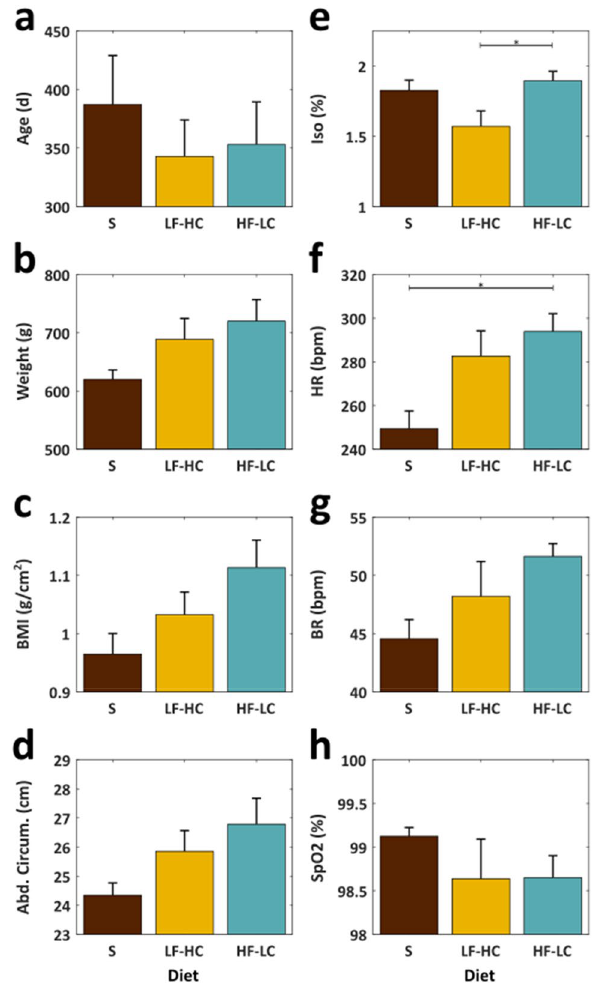
Figure 2. Various metrics for the animals, categorized by diet. Diet types are standard (S), low fat high carbohydrate (LF-HC) and high fat low carbohydrate (HF-LC). Significant differences (p ≤ 0.05) are denoted with